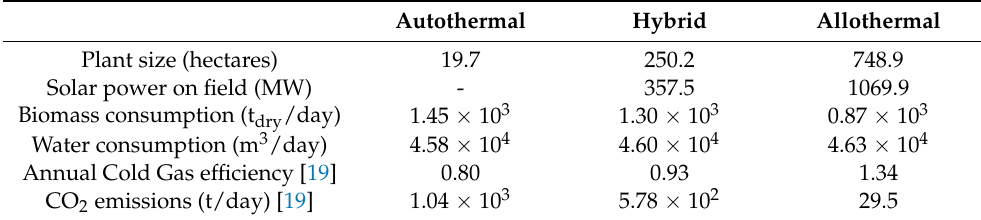
Table 3. Comparison between the three studied processes at DC = 150,000 kg H2